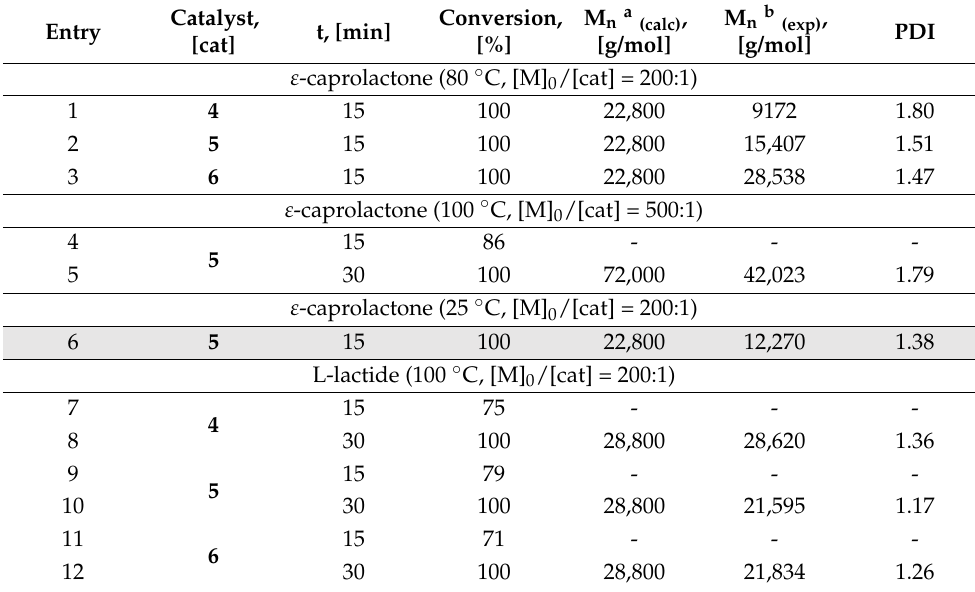
Table 1. Polymerization in bulk of ε -caprolactone and